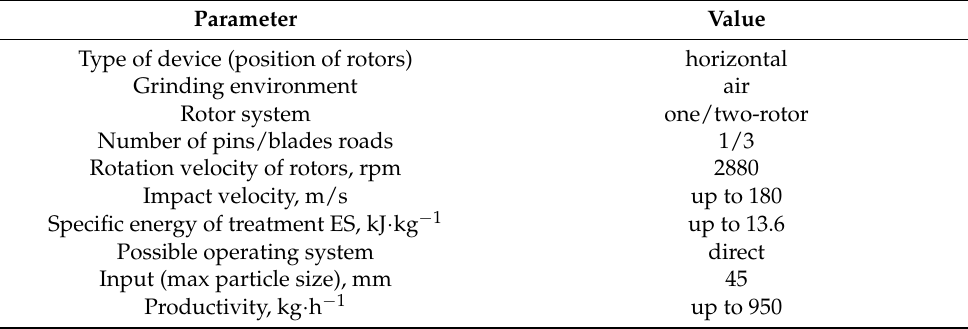
Table 2. Characteristics of the high-energy disintegration–mill DSL-350. Parameter Value Type of device (position of rotors) horizontal Grinding